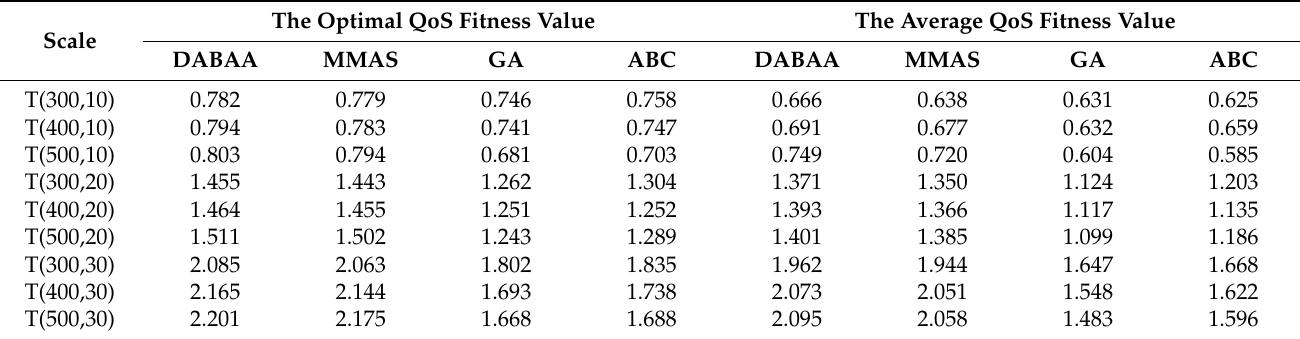
Table 6. The optimal and average QoS fitness